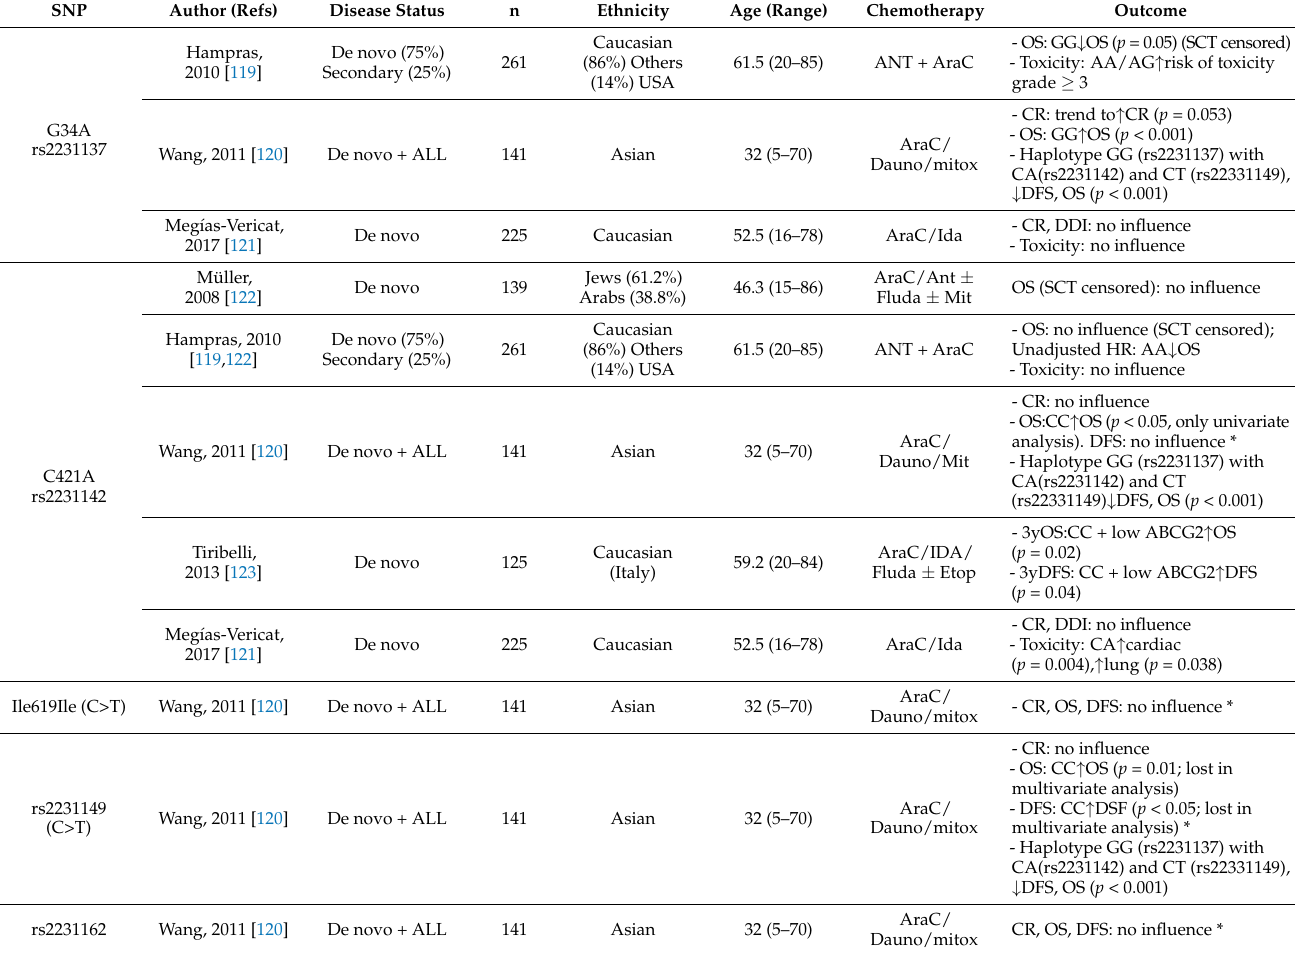
Table 2. Results of clinical studies for ABCG2 polymorphisms in